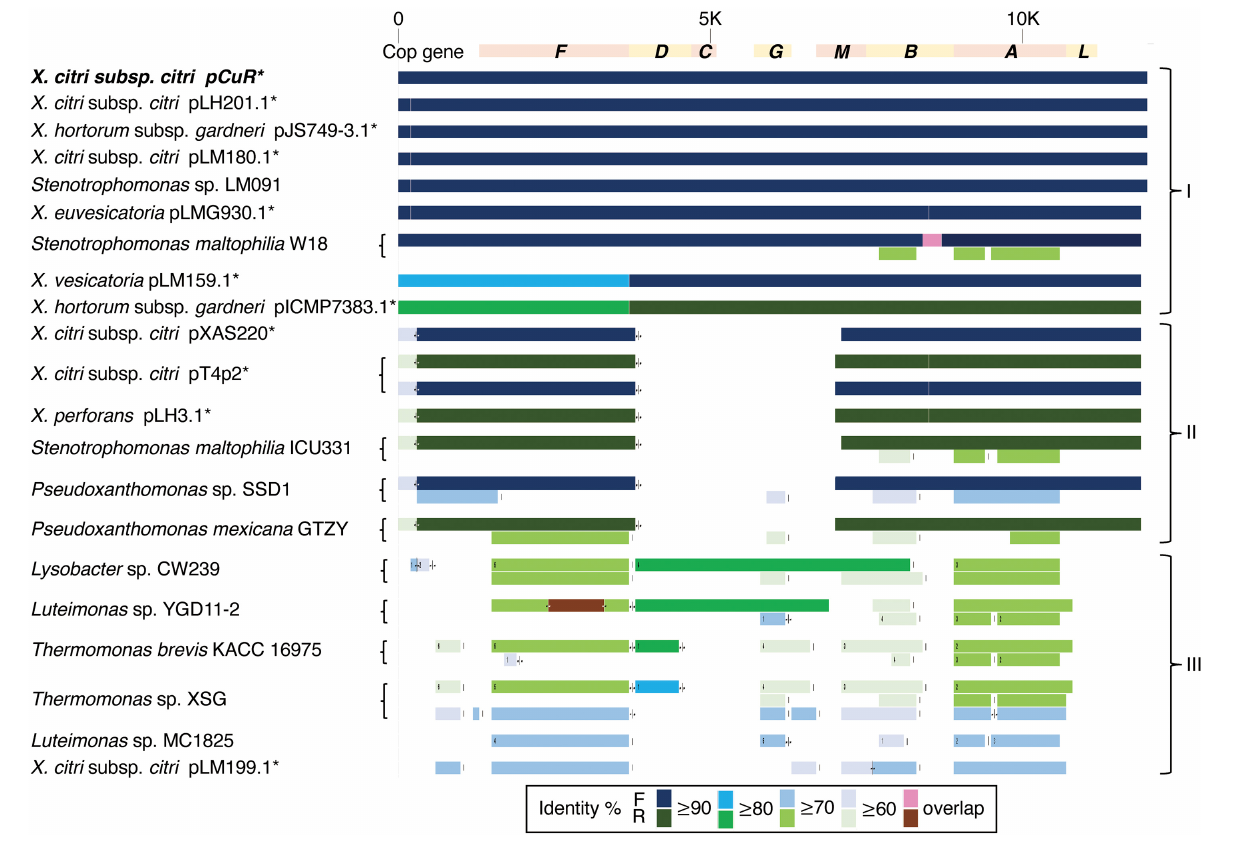
FIGURE 7 | Comparison of gene gain and loss in the copper resistance gene